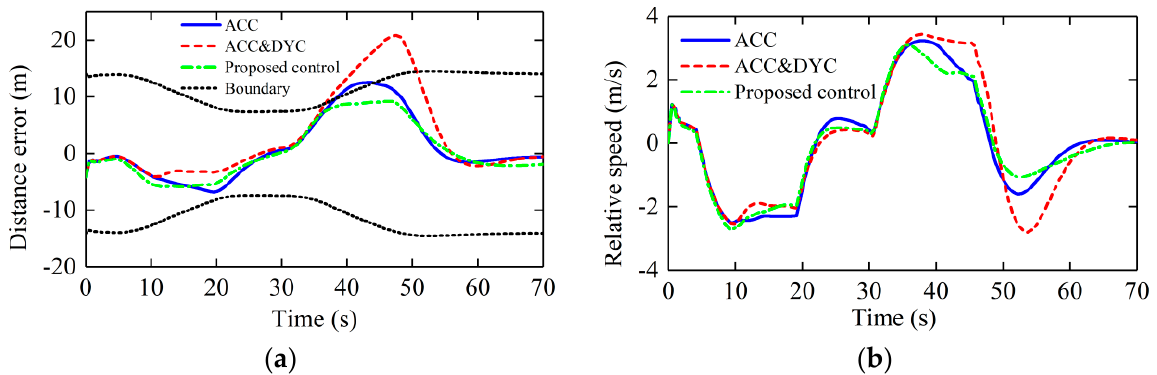
Figure 13. Longitudinal car-following errors, ( a ) Longitudinal car-following distance error, ( b ) Relative speed.